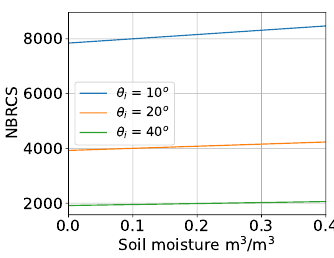
Figure 4. Relationship between averaged NBRCS and soil moisture, for a fixed geometry, vegetation parameters, and surface